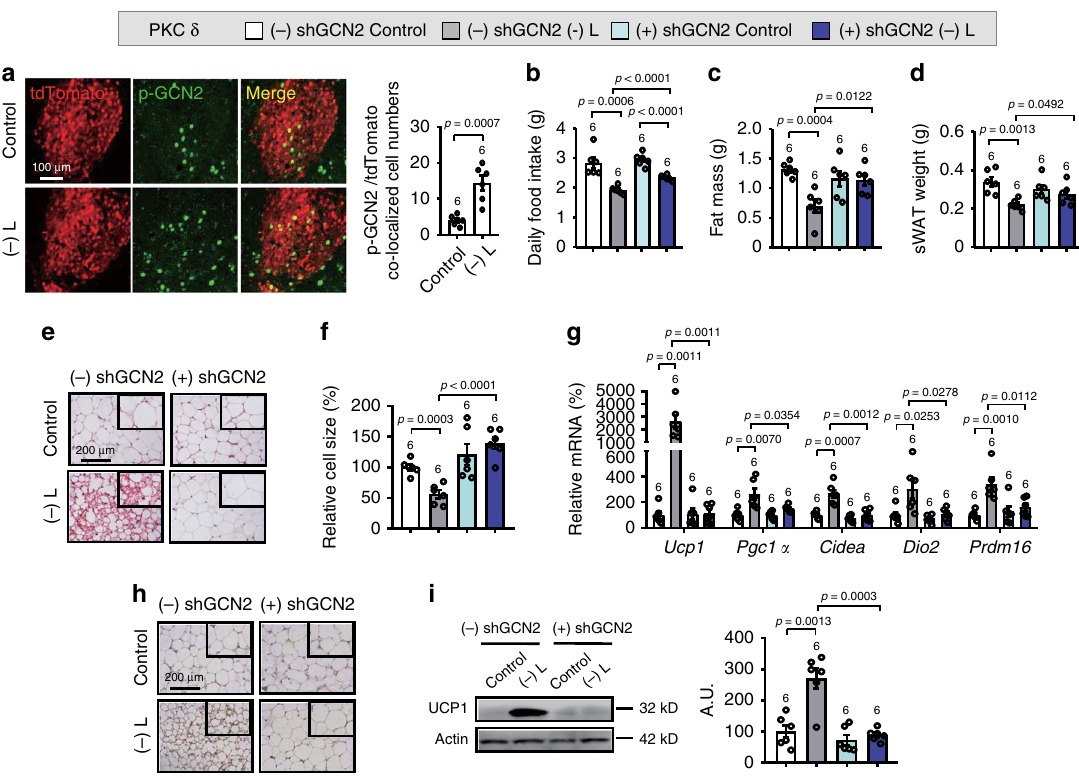
Fig. 4 Knockdown of GCN2 in amygdalar PKC- δ neurons blocks leucine deprivation-induced WAT browning. a Immuno fl uorescence (IF) staining for tdTomato (red), p-GCN2 (green) and merge (yellow) in central amygdala (CeA) sections (left), and quanti fi cation of p-GCN2 and tdTomato colocalized cell numbers (right). b Daily food intake. c Fat mass by NMR. d Subcutaneous WAT (sWAT) weight. e Representative images of hematoxylin and eosin (H&E) staining of sWAT. f sWAT cell size quanti fi ed by Image J analysis of H&E images. g Gene expression of Ucp1, Pgc1a, Cidea, Dio2 , and Prdm16 in sWAT by RT-PCR. h Representative images of immunohistochemistry (IHC) of UCP1 in sWAT. i UCP1 protein in sWAT by western blotting (left) and quanti fi ed by densitometric analysis (right); A.U.: arbitrary units. Studies for a were conducted using 12- to 14-week-old male PKC- δ -Cre-Ai9 mice fed a control (Control) or leucine-de fi cient [(-) L] diet for 3 days; studies for b – i were conducted using 13- to 16-week-old male PKC- δ -Cre mice receiving AAVs expressing GFP (PKC δ − shGCN2) or shGCN2 (PKC δ + shGCN2) fed a Control or (-) L diet for 3 days. Data are expressed as the mean ± SEM ( n represents number of samples and are indicated above the bar graph), with individual data points. Data were analyzed by two-tailed unpaired Student ’ s t test for a , or one-way ANOVA followed by the SNK (Student – Newman – Keuls) test for b – i . Source data are provided as a Source data fi